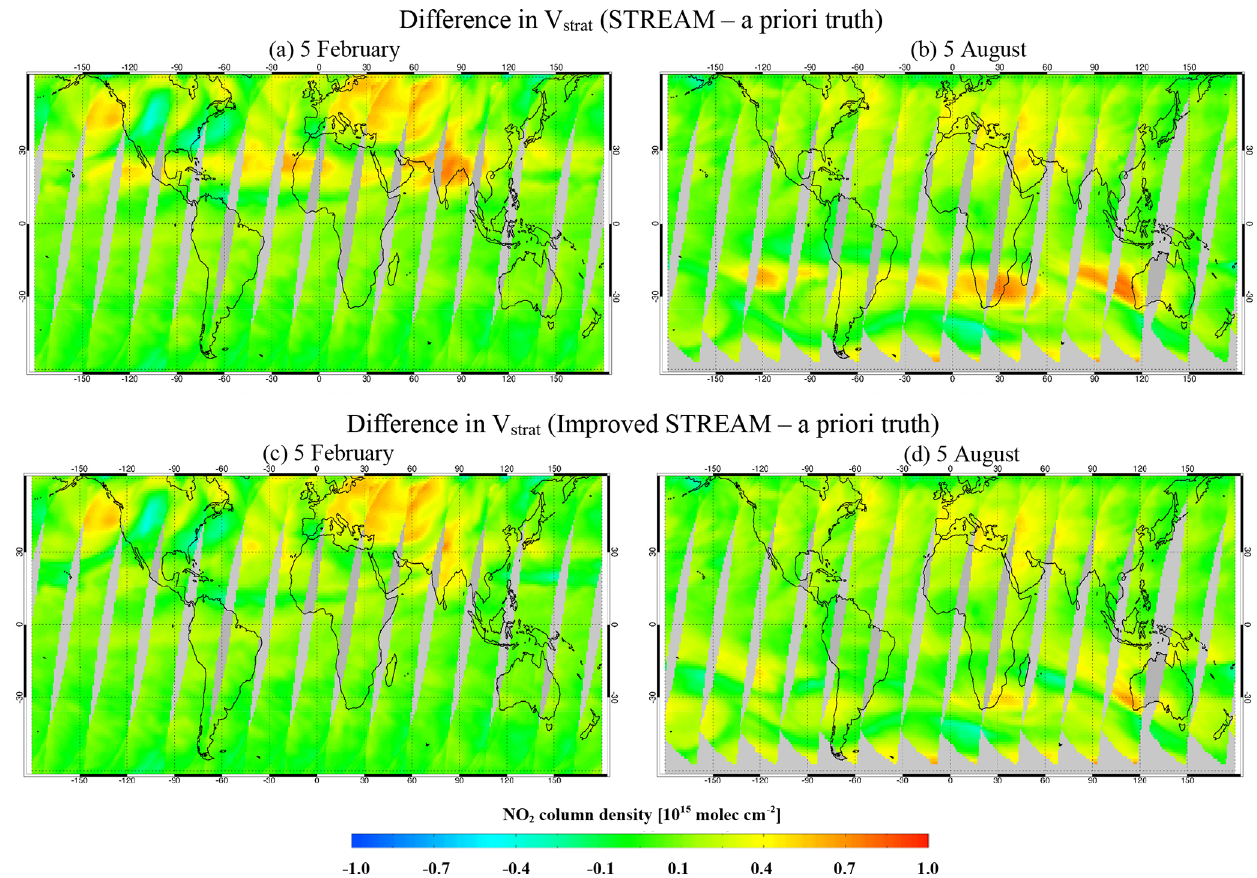
Figure 8. Difference in the stratospheric NO 2 columns estimated from STREAM and modelled by C-IFS on 5 February (a) and 5 August (b) 2009. Panels (c) and (d) show STREAM with improved latitudinal